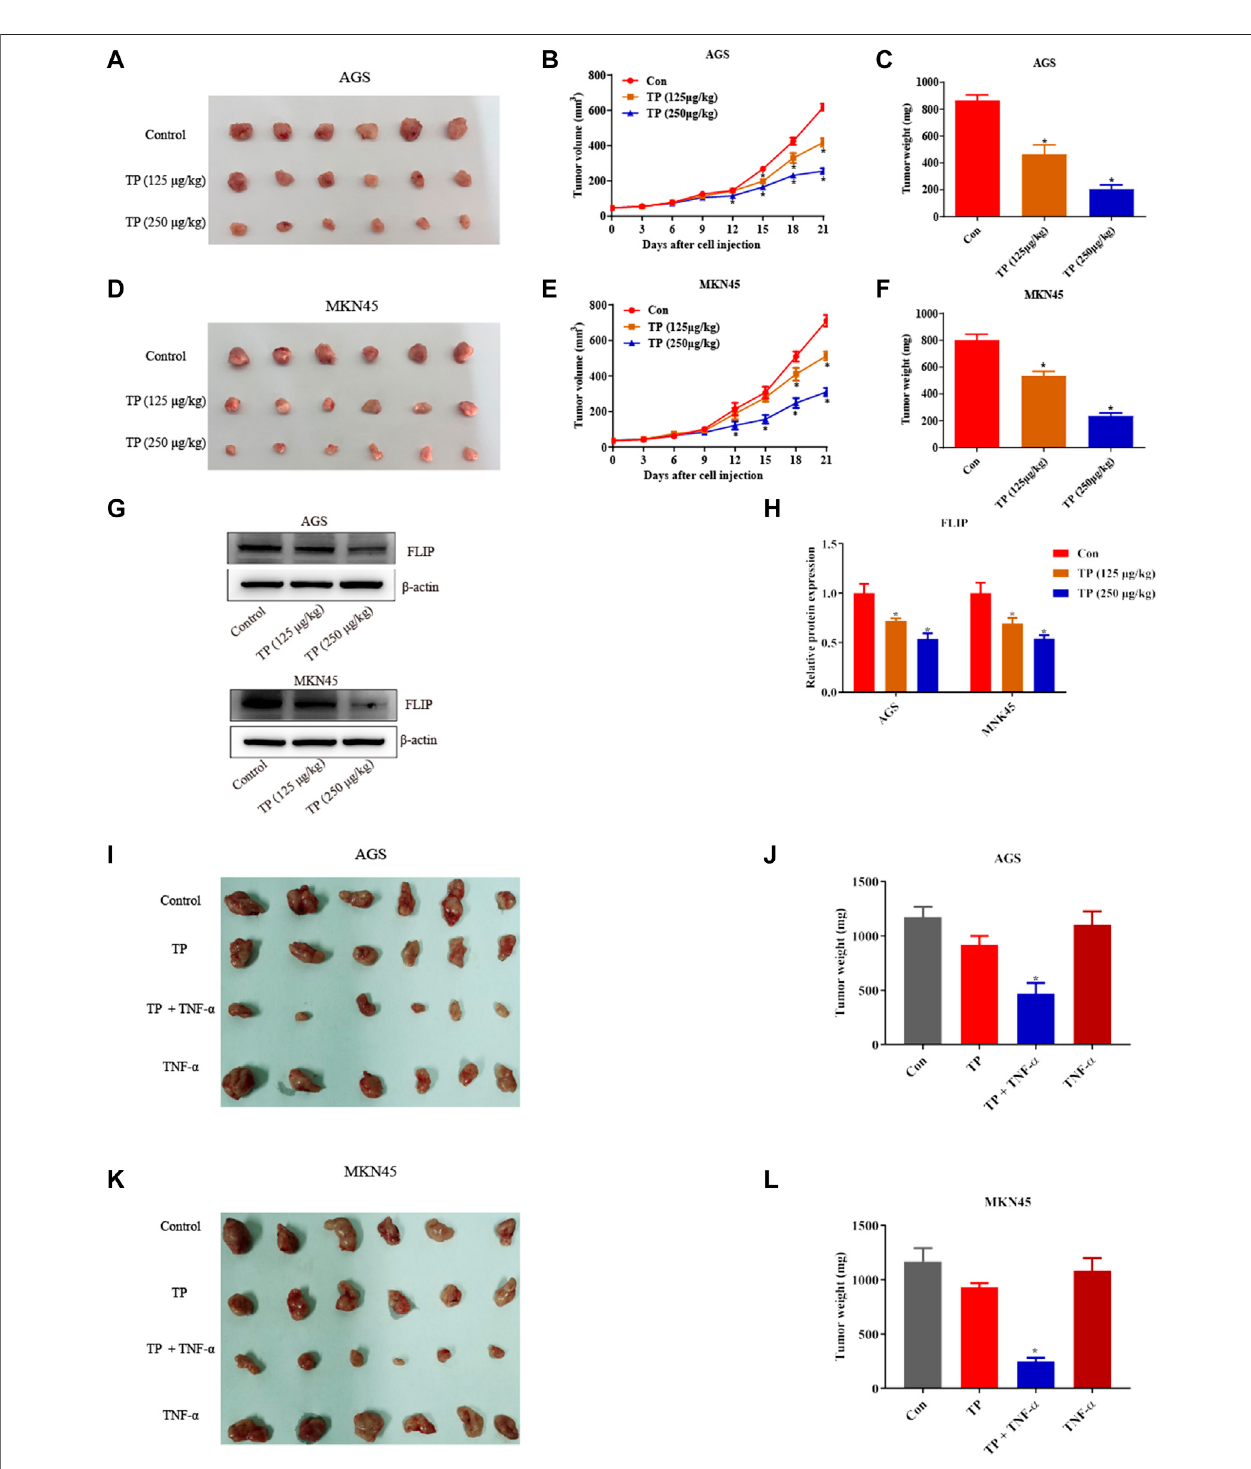
FIGURE 7 | TP inhibited the growth of AGS and MKN45 cells in vivo . (A) Images of tumor size when nude mice were subcutaneously injected with AGS cells and treated with TP (125 μ g/kg or 250 μ g/kg) for 3 weeks. (B – C) Tumor volume and weight of mice injected with AGS cells treated with TP. (D) Images of tumor size when nude mice were subcutaneously injected with MKN45 cells and treated with TP (125 μ g/kg or 250 μ g/kg) for 3 weeks. (E – F) Tumor volume and weight of mice injected with MKN45 cells treated with TP. (G – H) Representative western blots and relative intensity of protein bands of FLIP in mice injected with AGS and MKN45 cells and treatedwithTP(125 μ g/kg or250 μ g/kg). (I – L) Images oftumor size andweight ofnude mice injected withTP(125 μ g/kg) and TNF- α (5 μ g/kg) for3weeks.Results were expressed as mean ± SEM, and statistical analysis was performed using one-way ANOVA or two-way ANOVA followed by Tukey ’ s multiple comparison test. * p < 0.05 ( n ≥ 3). * p compared with the control